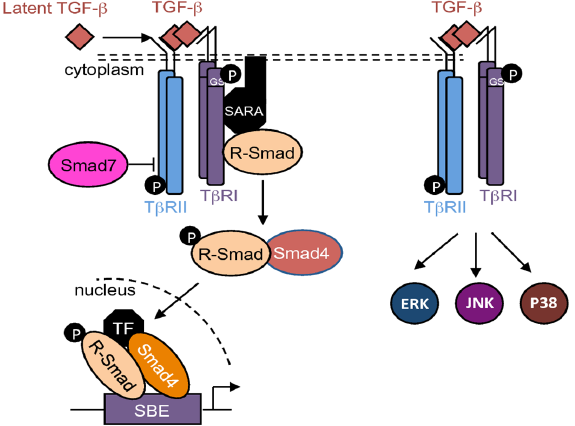
Figure 2. TGF ‐ β signaling pathways. Schematic representation of the canonical and non ‐ canonical Figure 2. TGF- β signaling pathways. Schematic representation of the canonical and non-canonical TGF ‐ β signaling pathways. R ‐ Smad: receptor ‐ regulated Smad; SBE: Smad ‐ binding element; TF: TGF- β signaling transcription factor.